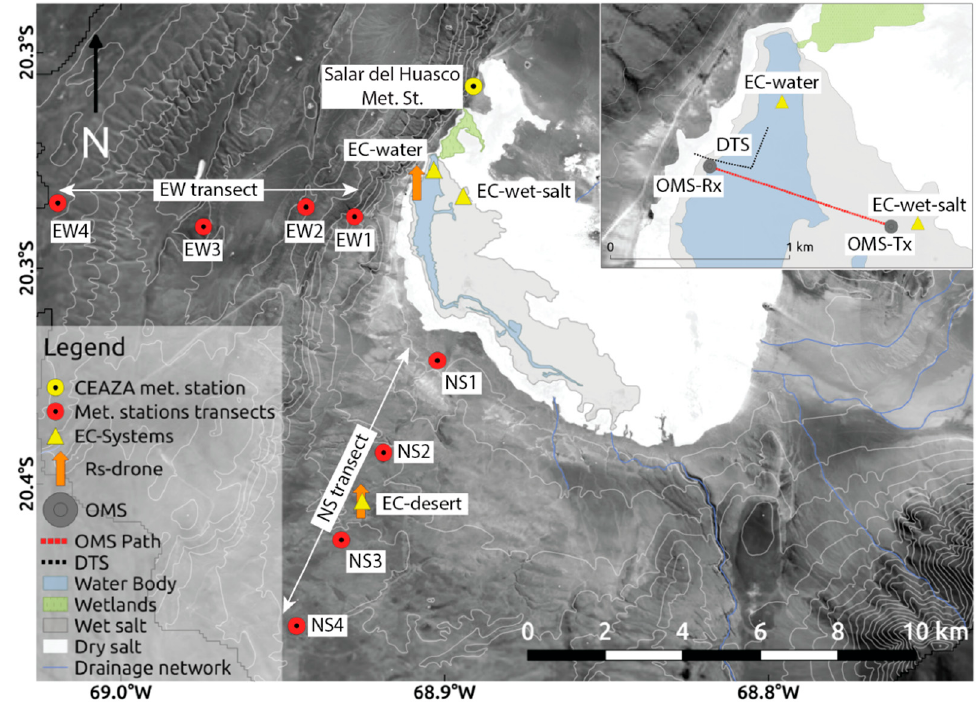
Figure 2. Location of the instruments in the E-DATA field campaign.